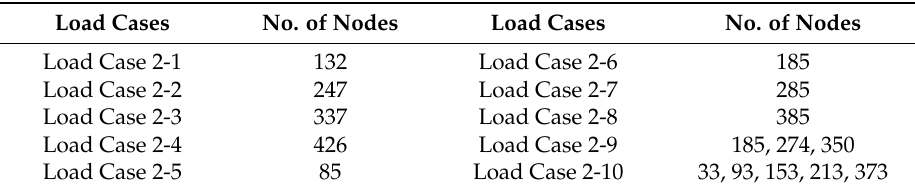
Table 6. Number of nodes excited in Load Case 2-1 to